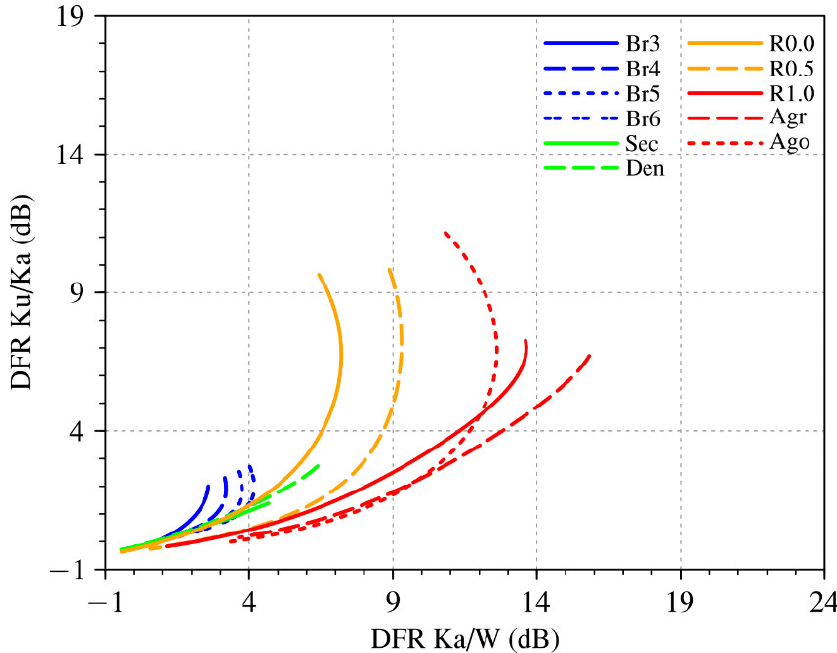
Figure 3. Modeled triple-frequency signatures for various snow particles including bullet rosettes (Br), sector (Sec), dendrite (Den), dendrite aggregates (R) and rosette aggregates (Ag). Yin et al. [7] grouped snow particle models based on their triple-frequency signatures. Accordingly, we classified snow particles into three groups and calculated their averaged triple-frequency signatures, respectively. Modeled triple-frequency signatures overlaid on the normalized occurrence frequencies of observed triple-frequency signatures are shown in Figure 4. It is worth noting that DFR Ku/W is also used as x-axis (right panel of Figure 4) since DFR Ku/W, the sum of DFR Ku/Ka and Ka/W, also contains the information of particle bulk effective density. Type A particles include bullets rosettes (R3 to R6), sectors (Sec) and dendrites (Den). Type B particles include unrimed and lightly rimed particles with ELWPs of 0.0, 0.1, 0.2 and 0.5 kg m − 2 from both scenarios A and B. Type C particles include heavily rimed (ELWPs of 1.0 and 2.0 kg m − 2 from scenarios A and B) and aggregated (Agr and Ago) particles. It is found that type B and C particles can explain most observed triple-frequency signatures, while type A particles only occupy a specific region of the triple-frequency plane where DFR values are both small. A hook feature of observed triple-frequency signatures is evident when using DFR Ka/W as x-axis, which can only be explained by type B particles. In other words, pristine crystals (type A) are not abundant, while unrimed or rimed aggregates (type B and C) are prevalent in ice clouds. A hook feature of observed triple-frequency signatures is associated with large unrimed or lightly rimed aggregates with low density. Large DFR Ka/W values with relatively small DFR Ku/Ka values are closely related to small heavily rimed or aggregated particles with high